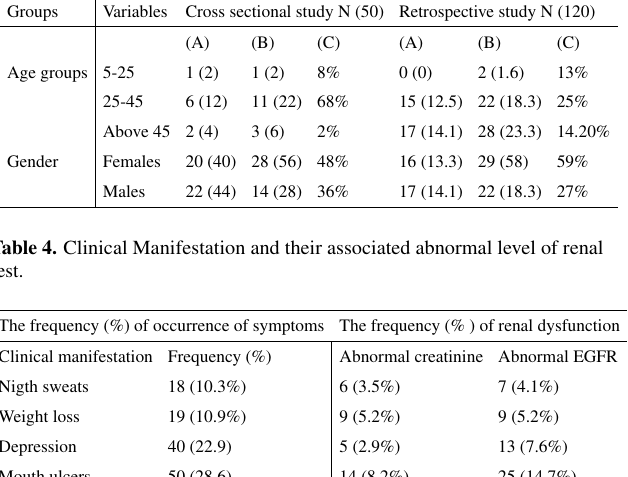
Table 3. Prevalence of abnormal Creatinine and EGFR according to age and gender in suspected patients at KDH, where the creatinine (kg / dl) (A), EGFR (ml / min)(B), and Prevalence (%)(C) are shown. Groups Variables Cross sectional study N (50) Retrospective study N (120)